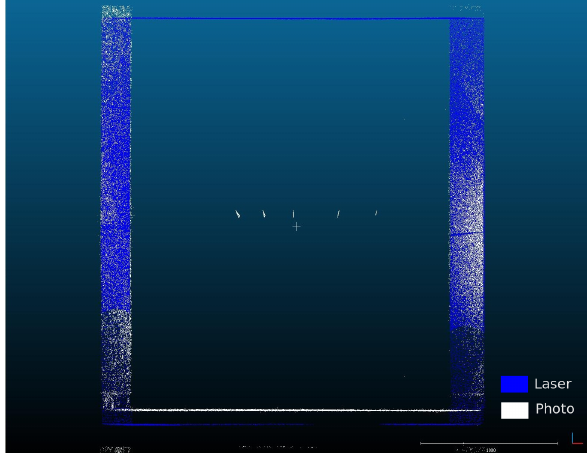
Figure 5: Distance comparison between a part of the IBM dense point cloud with the TLS point cloud